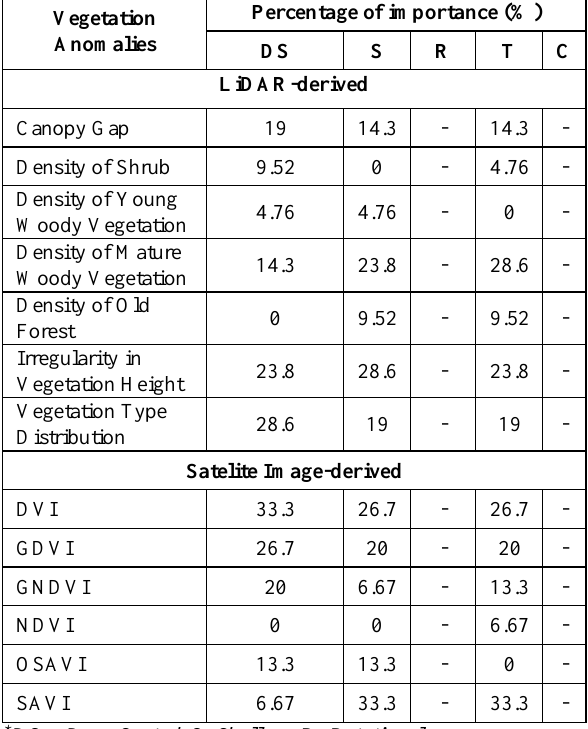
Table 8. Vegetation anomalies index in percentage for relict landslide activity with different landslide